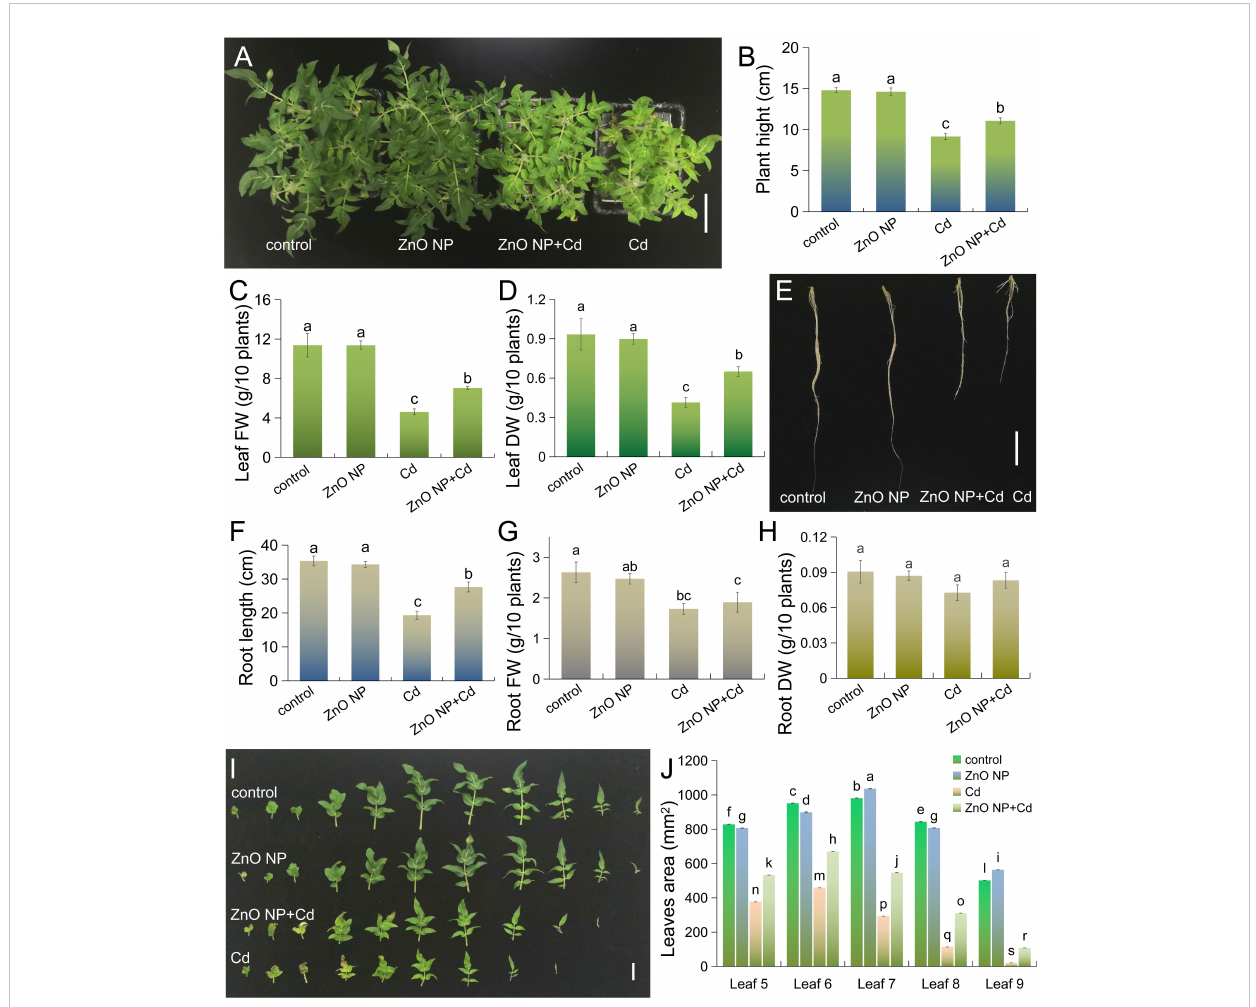
FIGURE 1 Foliar spraying with 50 mg·L -1 ZnO NPs alleviates Cd-mediated growth inhibition in tomato. (A) Three-week-old tomato seedlings were transferred to 1/4 strength fresh Hoagland solutions with or without 5 m M CdCl 2 for 12 days, and the seedlings were foliar sprayed with 50 mg·L -1 ZnO NPs (bar = 10 cm); the (B) plant height, (C) leaf fresh weight (FW), (D) leaf dry weight, (E, F) root length, (G) root FW, (H) root DW (bar = 5 cm), and (I, J) leaf area of tomato seedlings (bar = 2 cm) were measured. The results shown are the mean ± SE ( n =3; 15 plants/treatment/replicate), and different letters indicate signi fi cant differences ( P < 0.05 according to Tukey ’ s